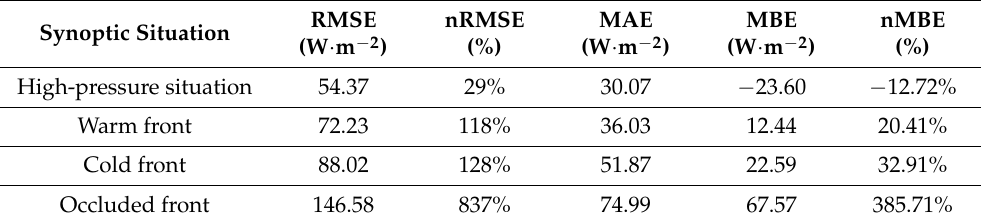
Table 7. Error values: RMSE, nRMSE, MAE, MBE, nMBE for individual synoptic situations (ERA5).